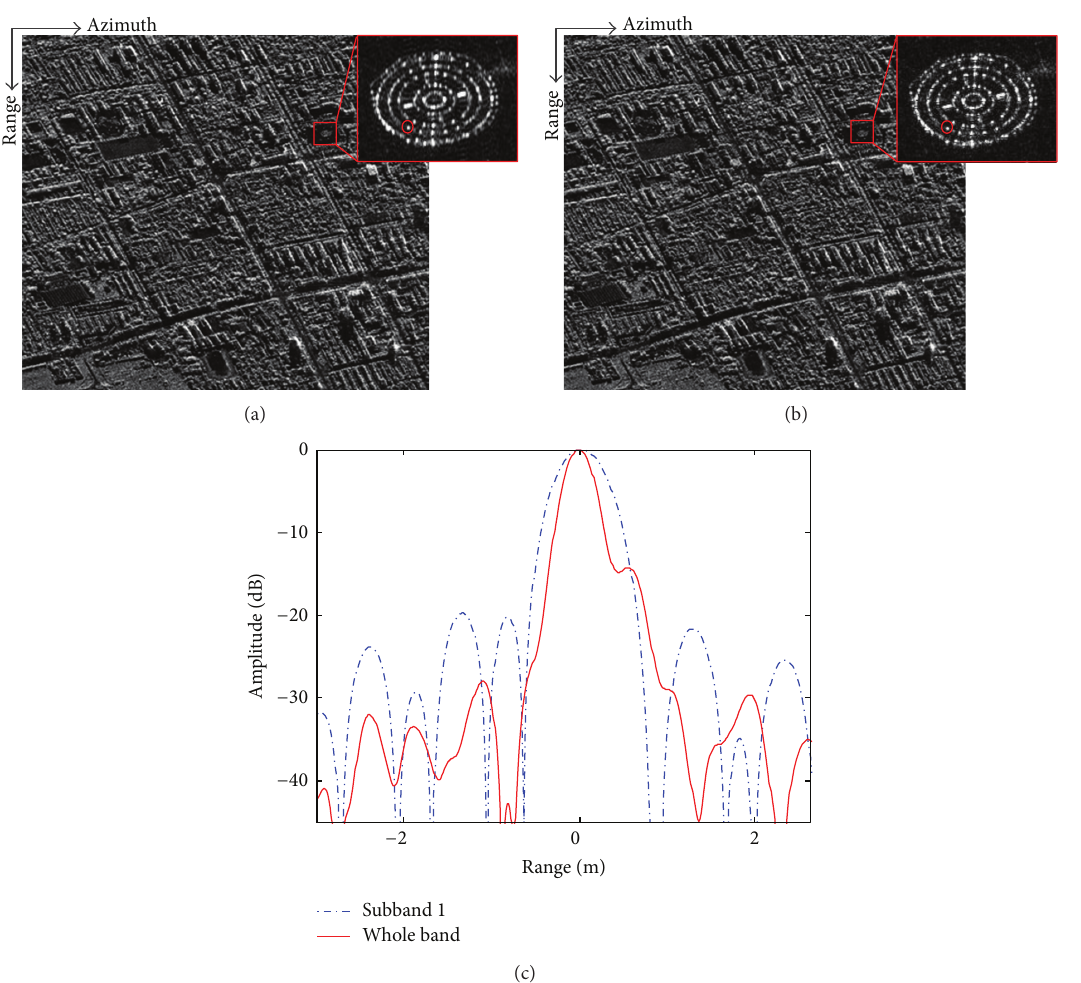
Figure 8: Results from an airborne spotlight SAR. (a) The image of subband 1 data after Doppler ambiguity resolving. (b) The image of the synthesized bandwidth data. (c) The range comparison of a point target in the amplified